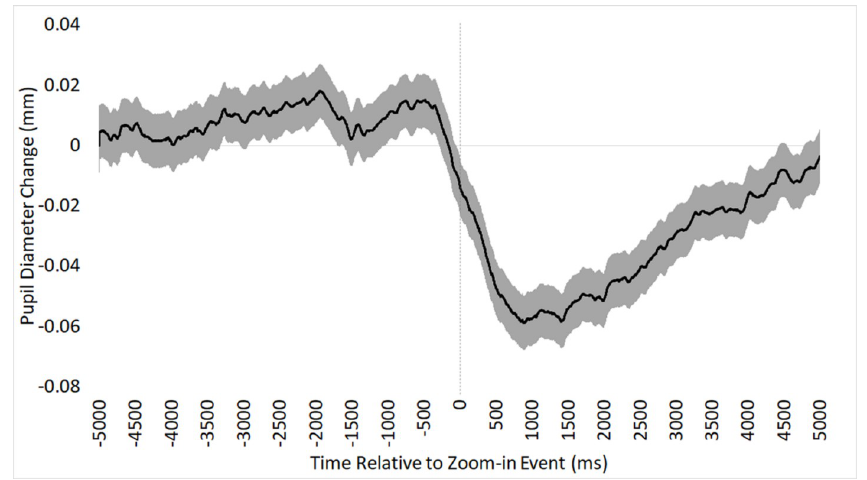
Fig 4. Hypothesis 3 phasic pupil diameter. Mean phasic pupil diameter response to zoom-in events over time (in ms), time-locked to the onset of a zoom-in event. Shaded region indicates standard error of the mean.